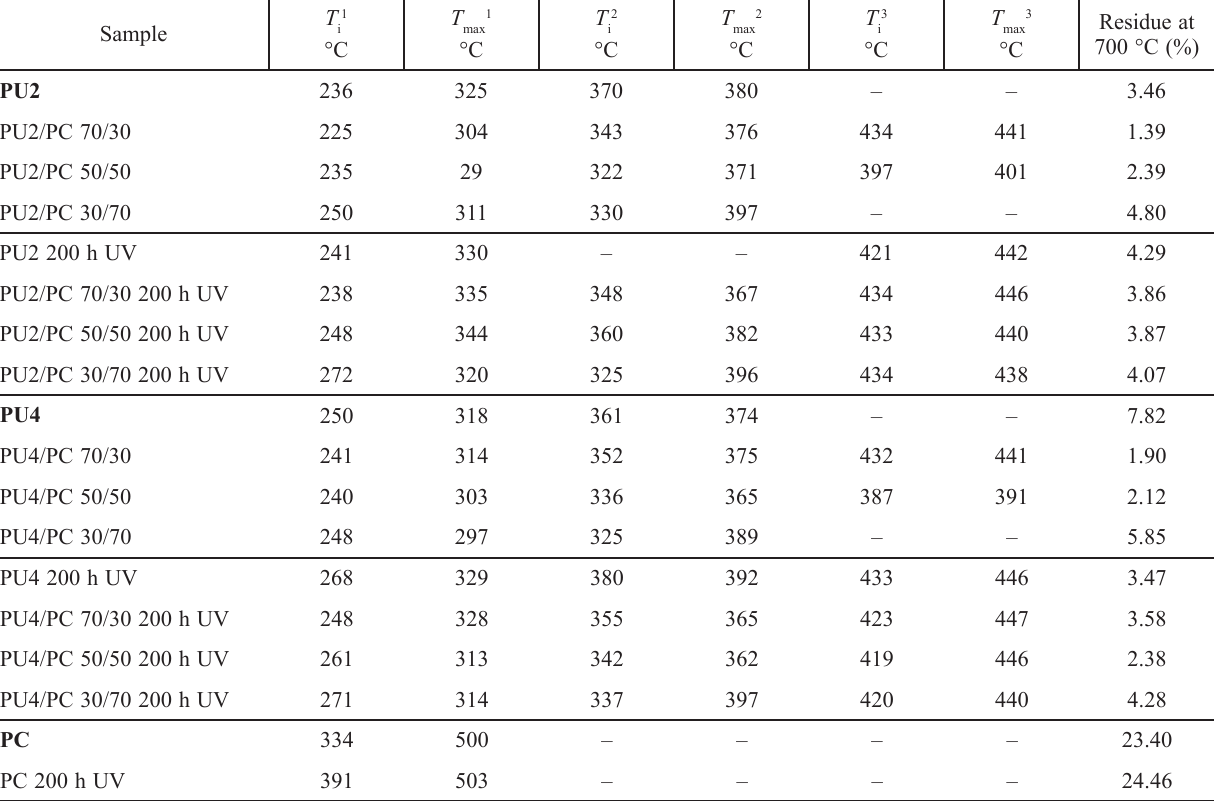
Table 4 – TGA results before and after UV irradiation